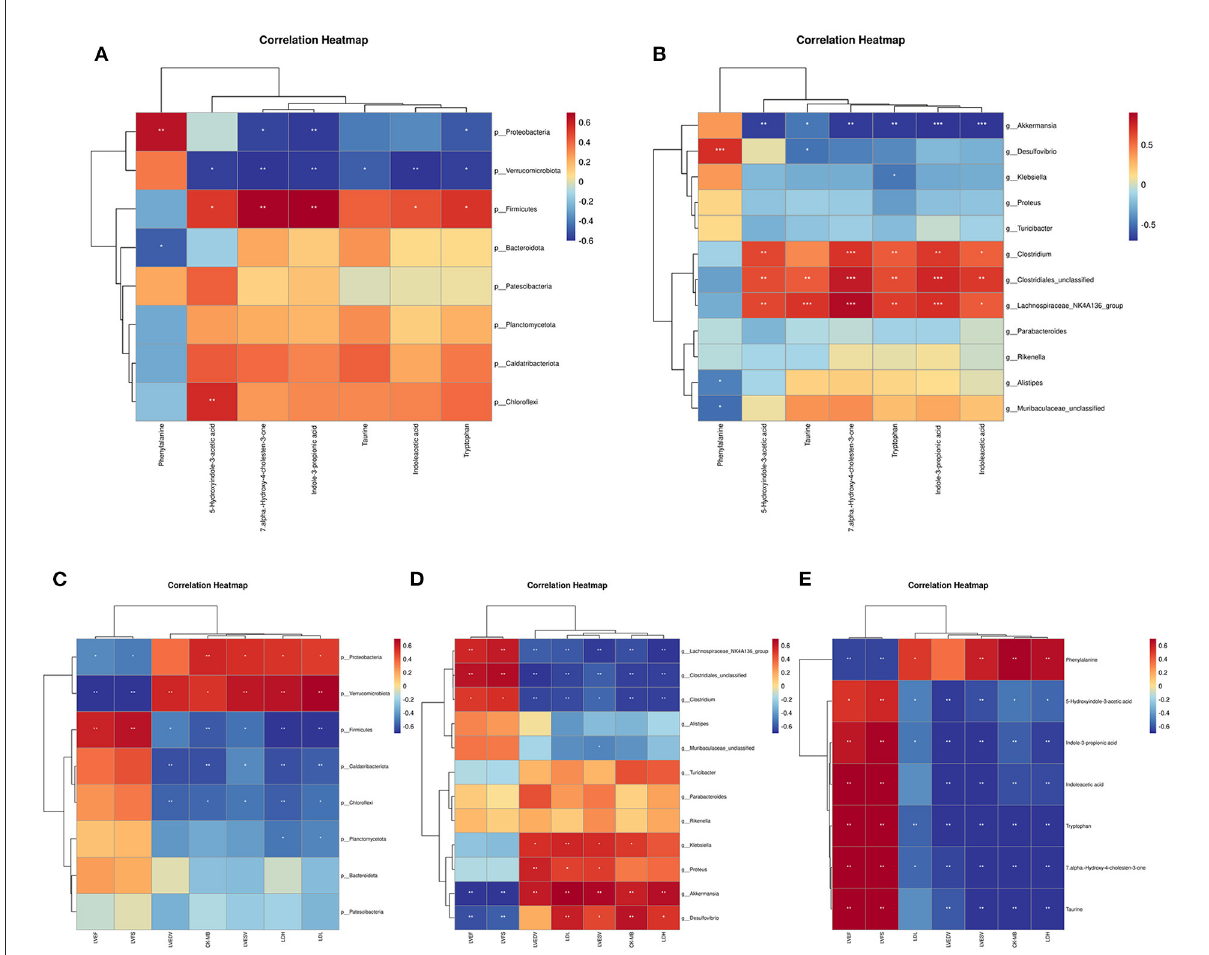
FIGURE11 The correlation analysis of gut microbiota, metabolites, cardiac function and myocardial injury parameters. (A) Spearman correlation between altered phylum bacterial taxa and altered metabolites. (B) Spearman correlation between altered genus bacterial taxa and altered metabolites. (C) Spearman correlation between altered bacterial taxa at the phylum level and echocardiographic and myocardial injury parameters. (D) Spearman correlation between altered bacterial taxa at the genus level and echocardiographic and myocardial injury parameters. (E) Spearman correlation between altered metabolites and echocardiographic and myocardial injury parameters. * P < 0.05, ** P < 0.01, and *** P <